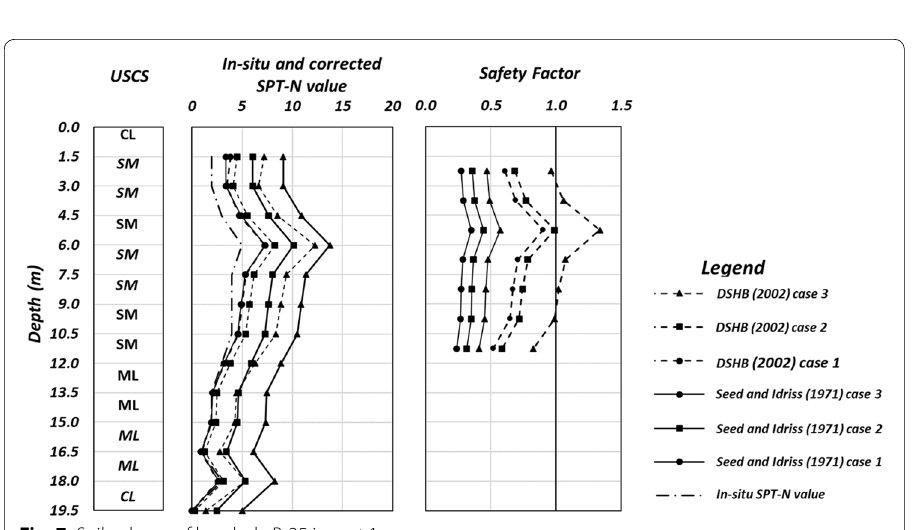
Fig. 7 Soil column of borehole B‑25 in part